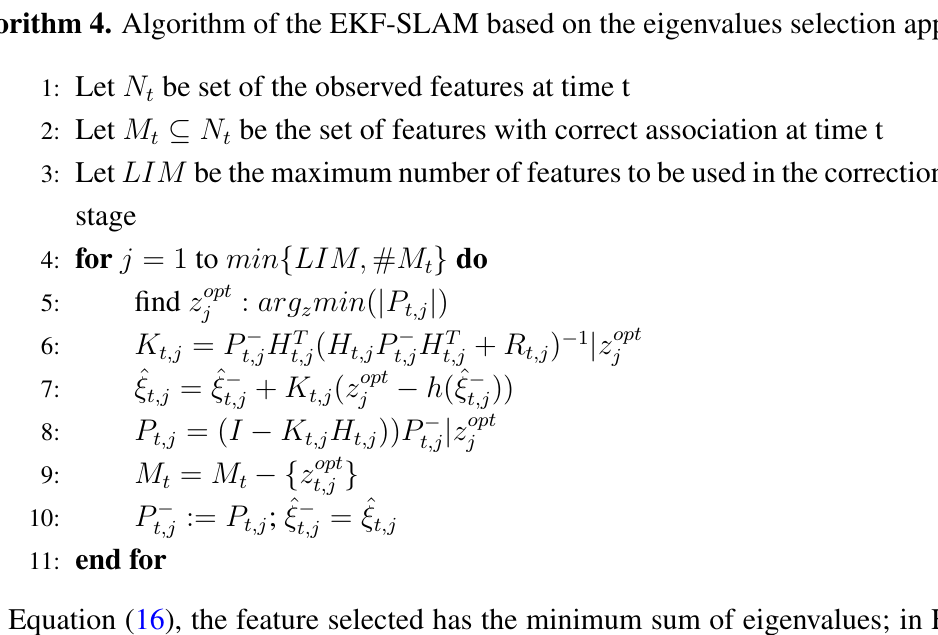
Algorithm 4. Algorithm of the EKF-SLAM based on the eigenvalues selection